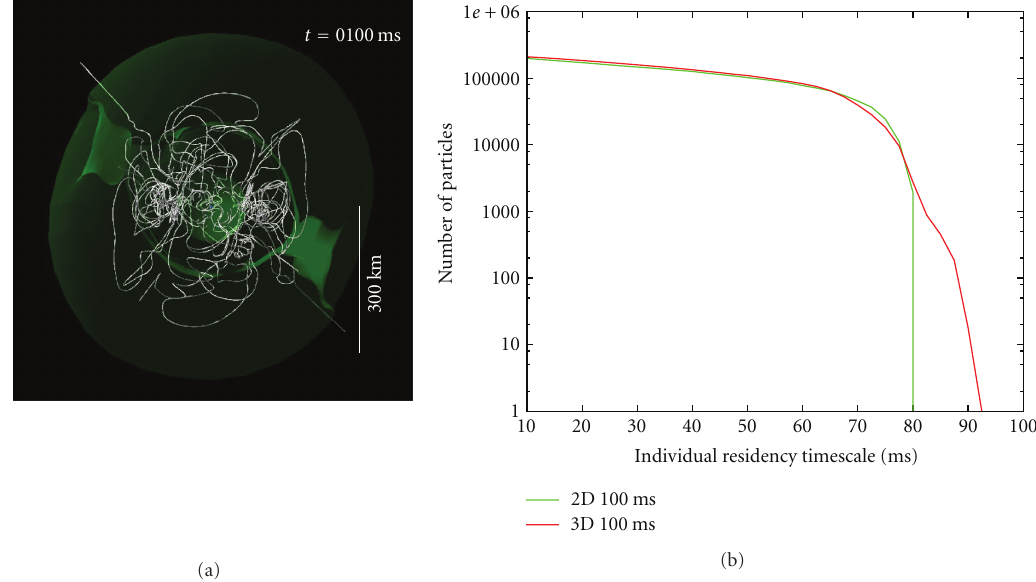
Figure 7: The left panel shows streamlines of selected tracer particles advecting through the shock wave to the PNS seen from the polar direction in our 3D model [139]. Several surfaces of constant entropy marking the position of the shock wave (greenish outside) and the PNS (indicated by the central sphere) are shown with the linear scale given in the right-bottom edge. The right panel shows the number of tracer-particles travelling in the gain region as a function of their individual residency time between the 2D and 3D model, at 100 ms after bounce. If the left panel were for 2D models, the streamlines would be seen as a superposition of circles with di ff erent diameters. The maximum residency timescale for the 3D model is shown to be longer than that in the corresponding 2D model. These figures are taken from [139].